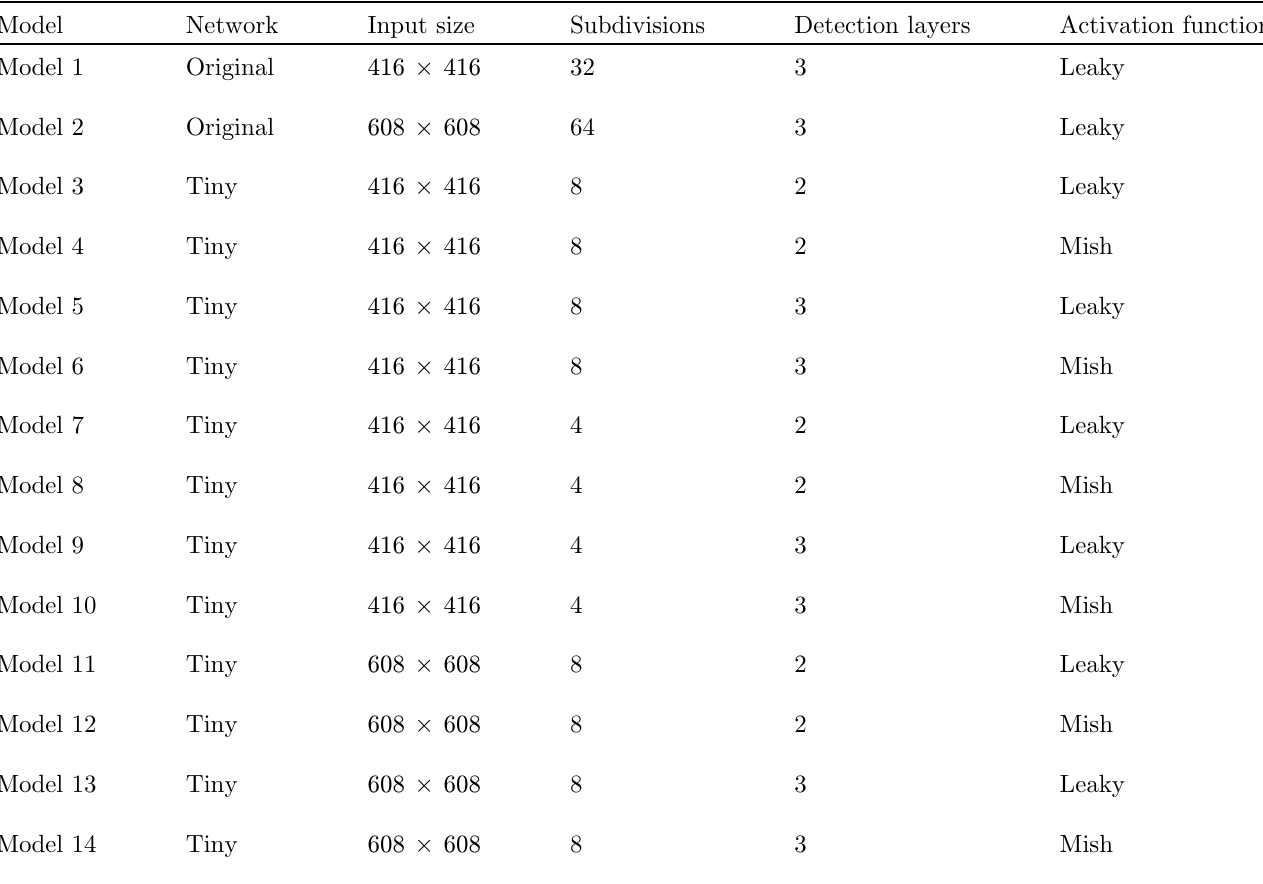
Table 1. Important parameter settings and con fi gurations of various YOLOv4 models.